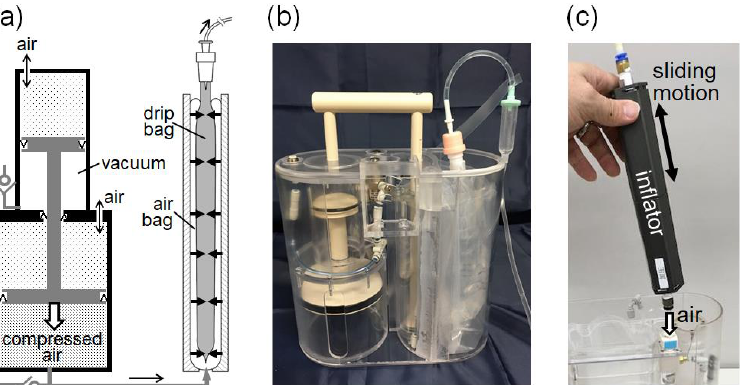
Figure 8. Prototype AIR-BAG. ( a ) Pressurizing mechanism acting on a drip bag comprises a vacuum piston cylinder built together with an air piston cylinder, and a sleeping-bag-shaped air bag in a separate compartment. ( b ) A transparent view of the prototype’s interior. ( c ) A hand-operated inflator with sliding motion is used to pump air into the compressed air chamber shown in ( a ), to push both the vacuum and air pistons back to the starting (standby)